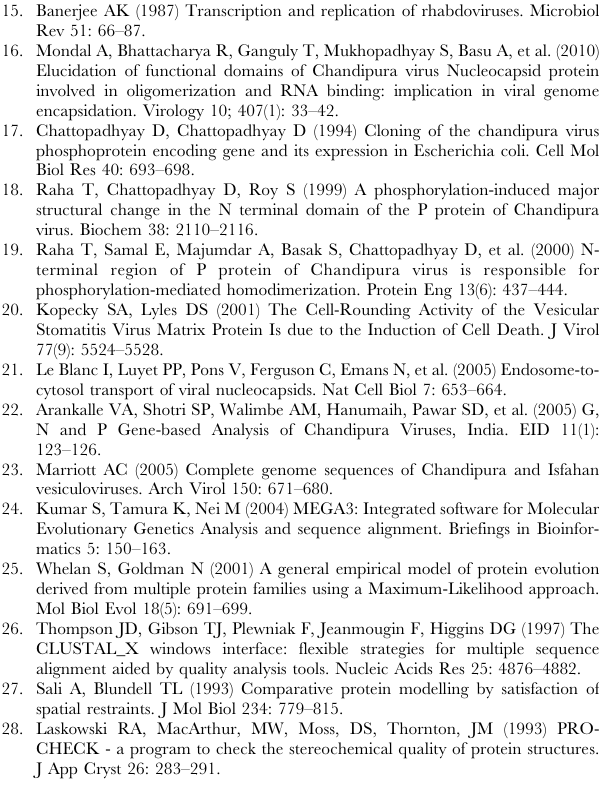
Figure S5 Leader and trailer sequences in the CHPV whole genome isolates. Table S1 Primers used for the amplification and sequencing of the CHPV whole genomes. Table S2 Predicted antigenic determinants (A) and conformational epitopes (B) in the G protein of